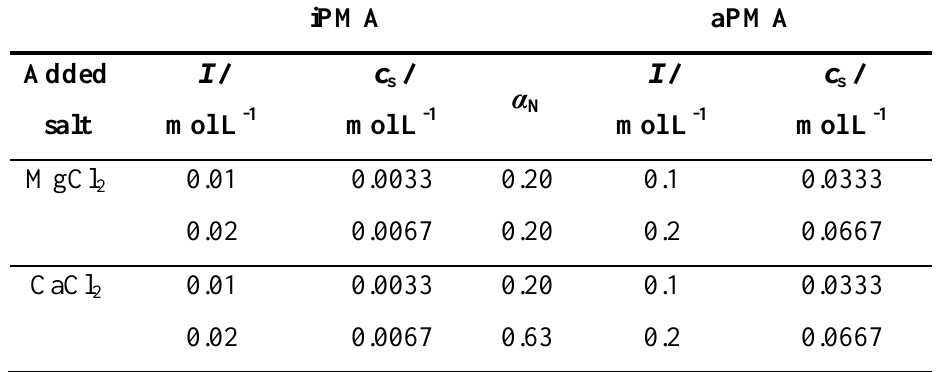
) of added metal chlorides (MgCl s = 0.022 mol L -1 ; α p